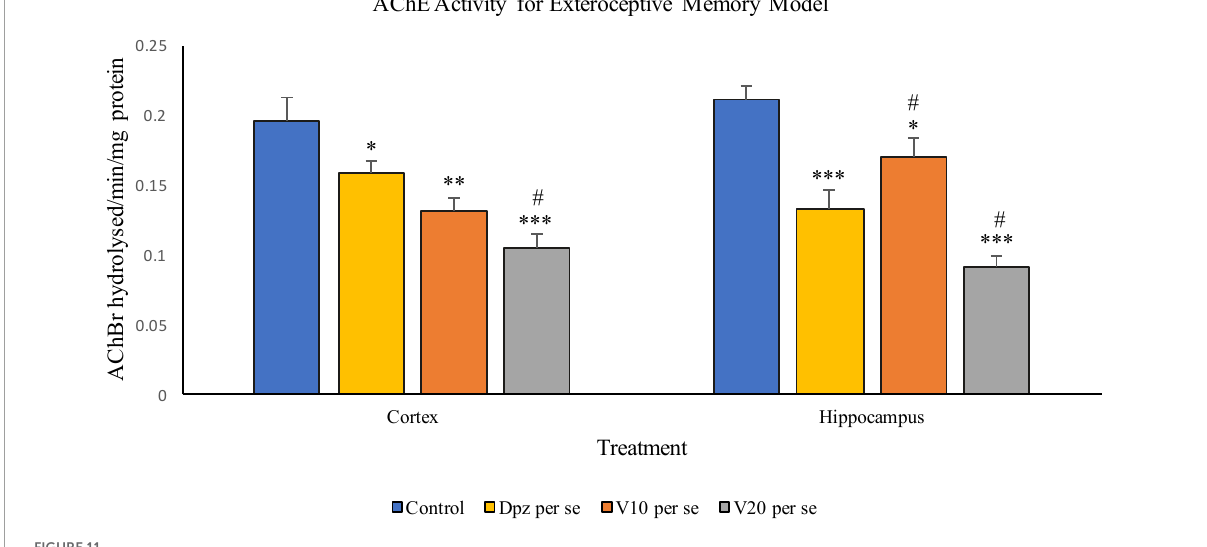
FIGURE11 Effect of vanillin and other treatments on AChE activity. Data are expressed as mean ± SEM. “***” denotes P < 0.001 with respect to the control group, “**” denotes P < 0.01 with respect to the control group, and “* denotes P < 0.05 with respect to the control group. “#” denotes P < 0.05 with respect to the standard treatment